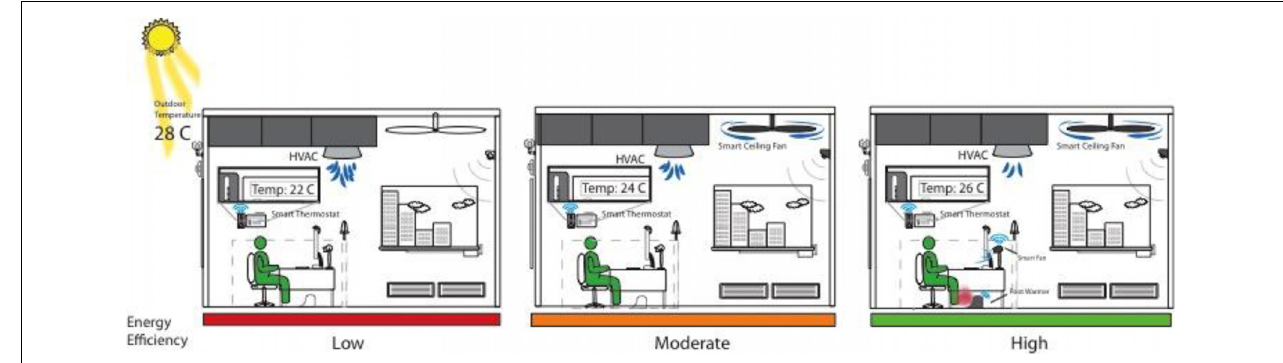
FIGURE 8 | A progression of improving energy efficiency in providing occupant thermal comfort by optimizing the orchestrated use of the HVAC system and PCSs in the occupied